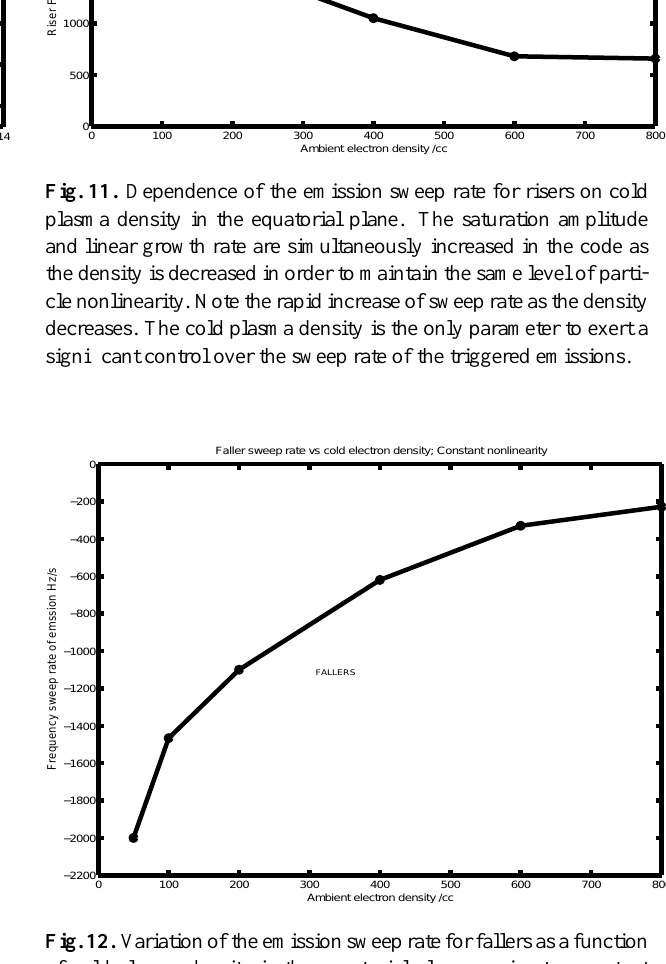
Fig. 12. Variation of the emission sweep rate for fallers as a function of cold plasma density in the equatorial plane, again at a constant nonlinearity. Again we note the strong control exerted on the sweep rate by the cold plasma density. However, the faller sweep rates are about one half of the corresponding riser sweep rate